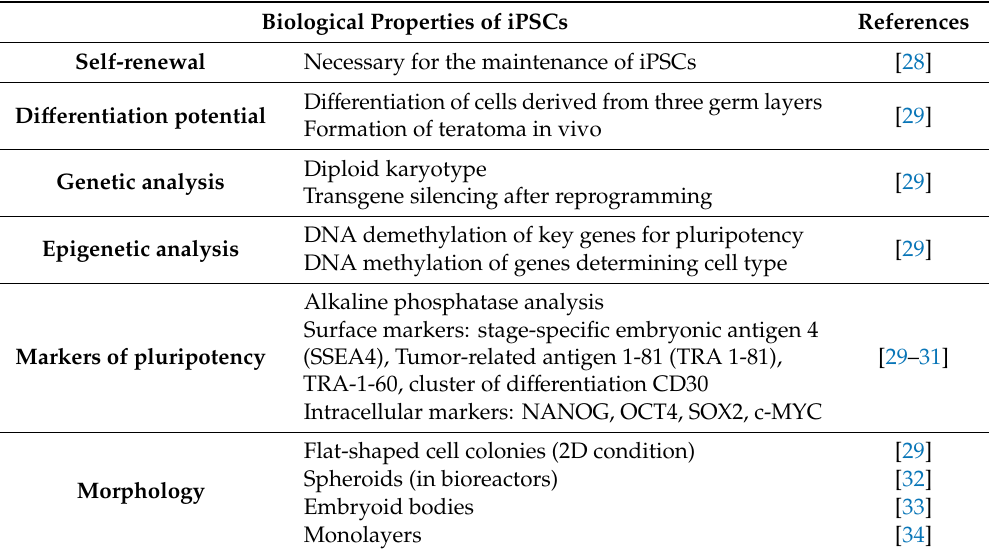
Table 1. Biological properties of